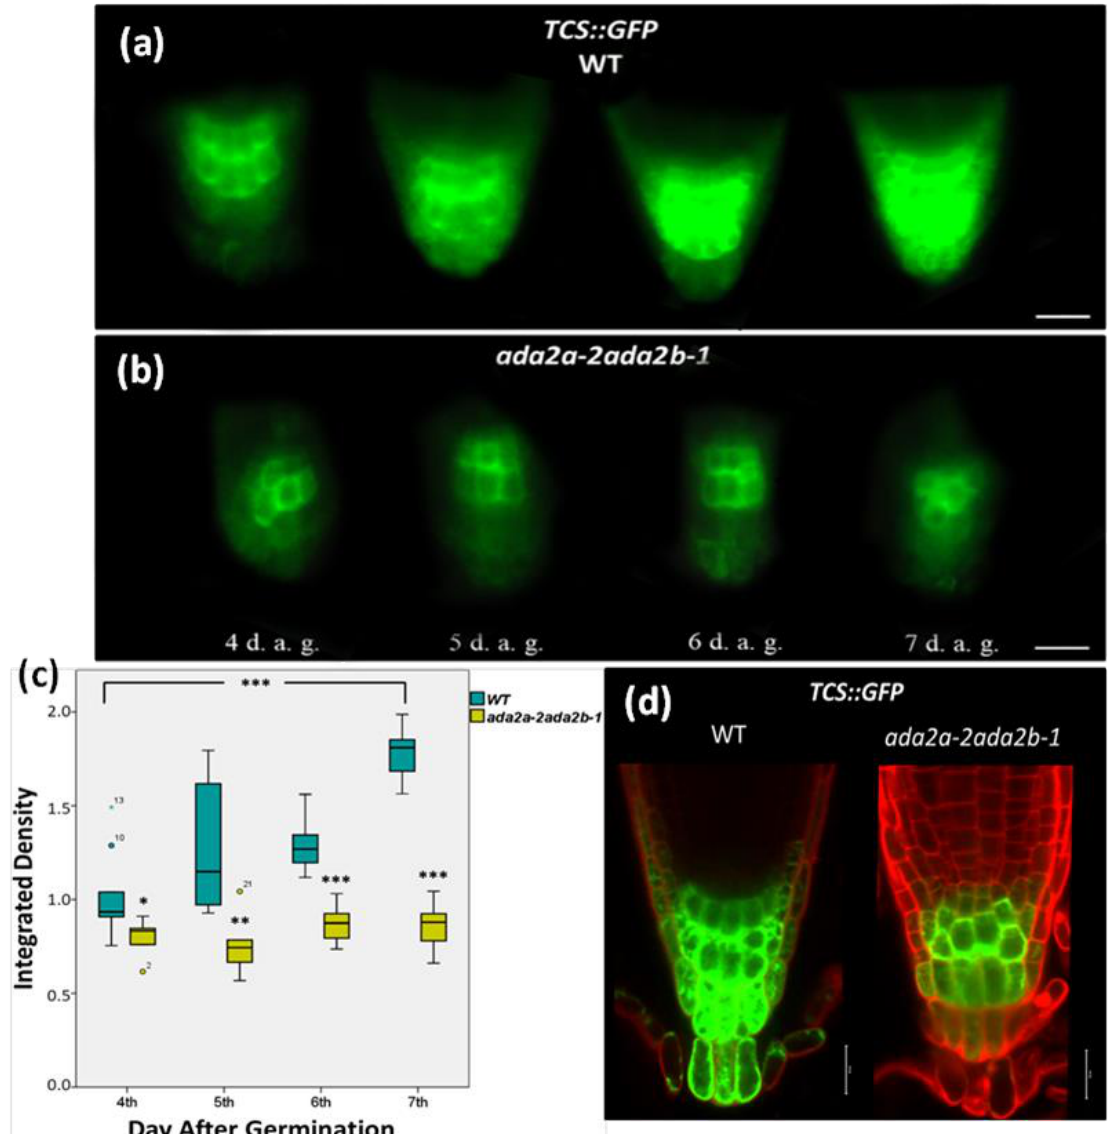
Figure 2. ADA2a and ADA2b affect cytokinin signaling at the first stages of root growth in Arabidopsis thaliana . The expression of reporter gene TCS :: GFP in roots of ( a ) wild type (WT) and ( b ) ada2a-2ada2b-1 double mutant plants 4, 5, 6, and 7 days after germination (d.a.g.). Scale bars represent 50 µm. ( c ) The graph indicates the fluctuation of fluorescence density between WT and ada2a-2ada2b-1 during root growth. The bars represent the range of the two quadrants, the horizontal line in the bar the median, while the terminals the minimum and maximum value of the data. Asterisks above bars ada2a-2ada2b-1 indicate statistical significance compared to the same d.a.g. of WT, while asterisks between brackets indicate the difference between 4th and 7th d.a.g., using an independent samples t -test: * p < 0.05, ** p < 0.01, and *** p < 0.001. ( d ) TCS :: GFP expression in 7-day-old roots of WT and ada2a-2ada2b-1 stained with iodide propidium is detected using confocal fluorescence microscopy. Scale bars represent 20 µ